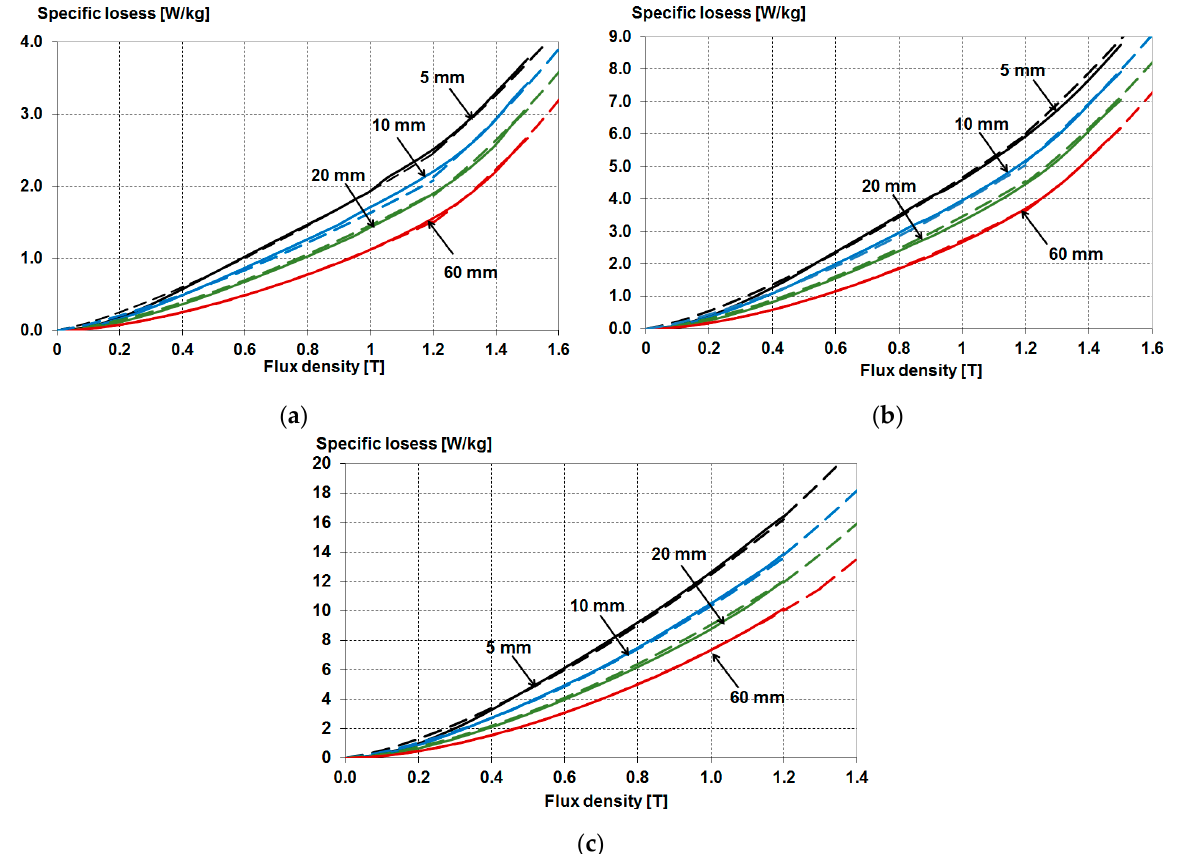
Figure 22. Measured and approximated loss characteristics of the M 270-35A sheet for different widths of laser-cut sheet samples at the frequency of 50 Hz ( a ), 100 Hz ( b ), and 200 Hz ( c ); (measured—solid line, estimated—dashed line).